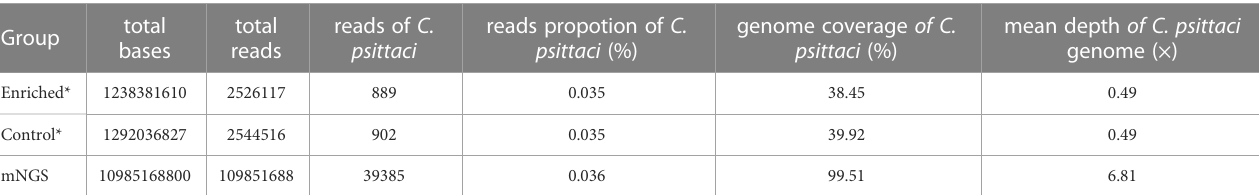
TABLE 1 Comparison of C. psittaci data in adaptive sequencing and mNGS. Group